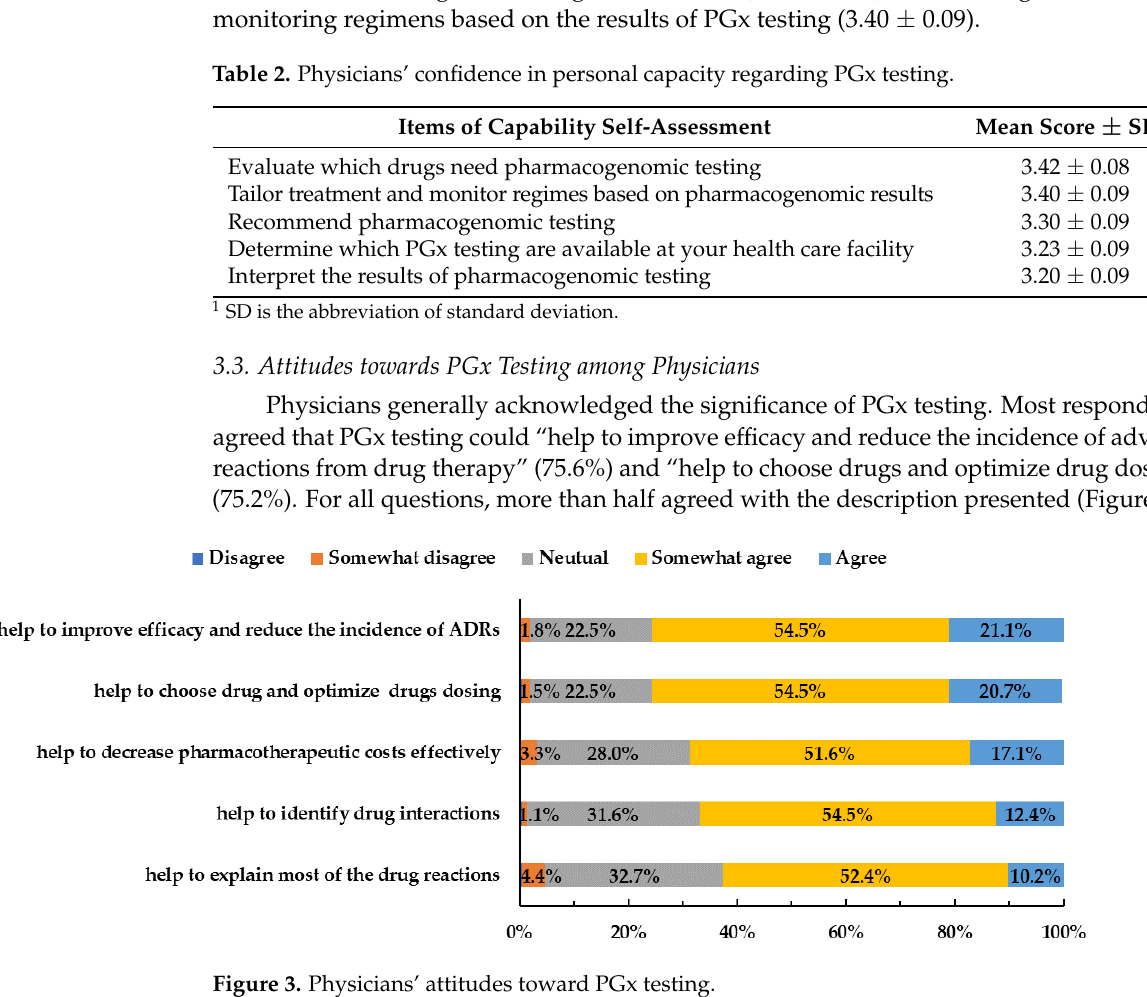
Figure 2. Physicians’ ways of learning information about pharmacogenomic testing.